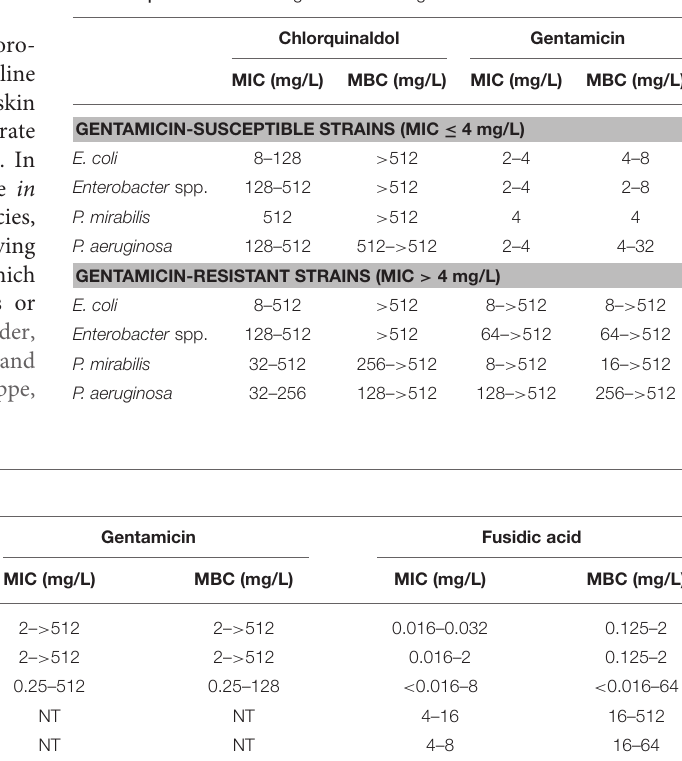
TABLE 2 | MIC and MBC ranges for Gram-negative bacterial